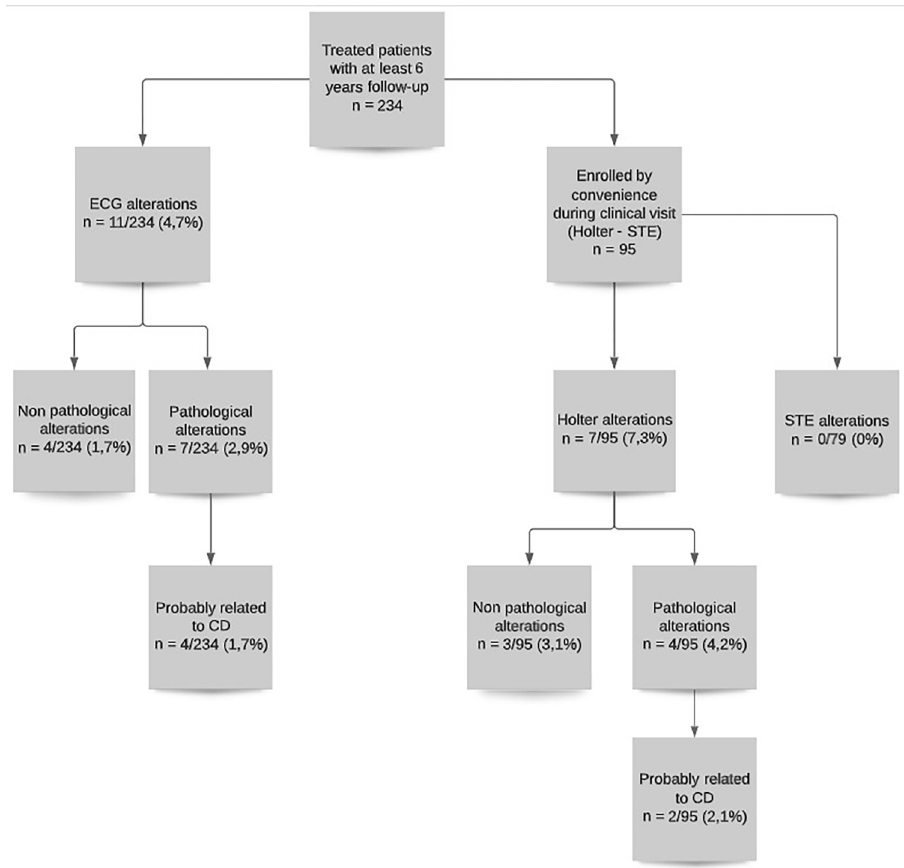
Fig 1. Flow chart of patient enrollment in the